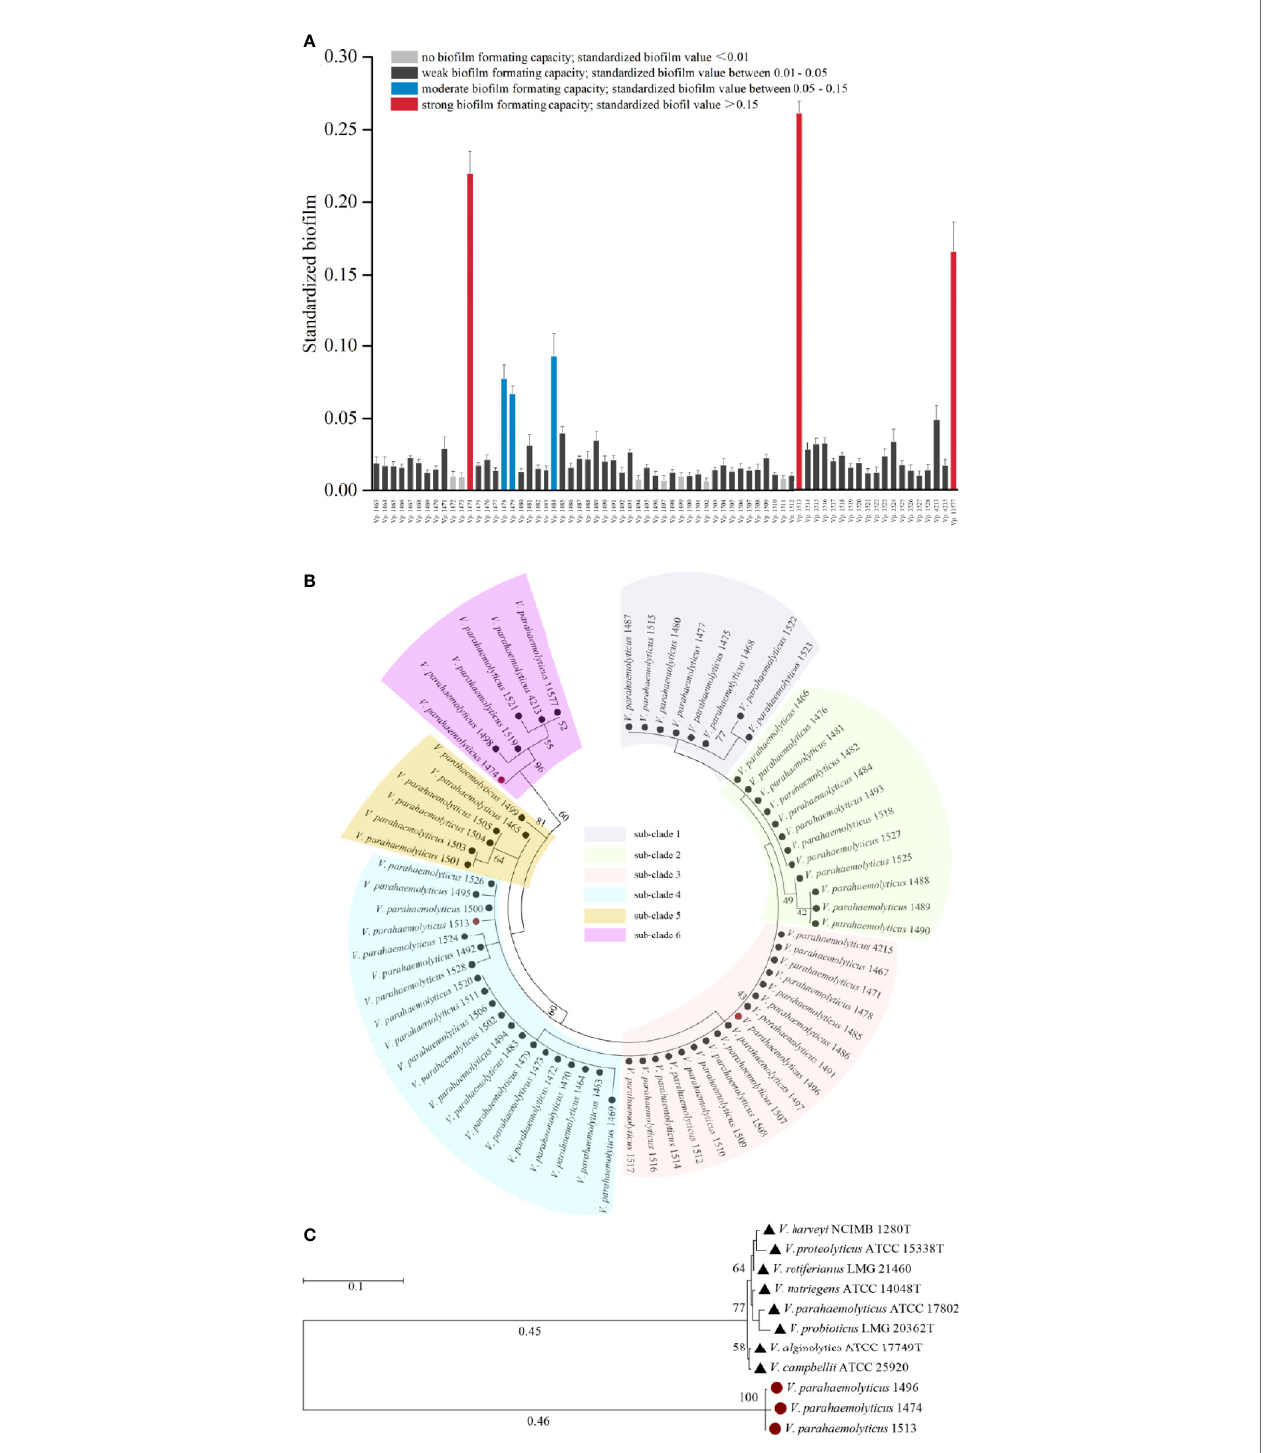
FIGURE 1 | Phylogenetic analysis and bio fi lm formation capacity of V. parahaemolyticus . (A) Standardized bio fi lms formed by 69 V . parahaemolyticus environmental strains. Based on the standardized bio fi lm values, the bio fi lm formation (BF) capacity of the strains was divided into four groups, viz., strong, moderate, weak, and no capacity. (B) Maximum likelihood tree of 69 V . parahaemolyticus environmental strains based on the 16S rDNA phylogenetic analysis. The bootstrap percentage value was obtained from 1000 samplings. The 69 strains were divided into 6 subclades. (C) Maximum likelihood tree for V. parahaemolyticus strains Vp . 1474, Vp . 1496, and Vp . 1513 based on the 16S rDNA phylogenetic analysis using type strains in Vibrio genus as reference. The bootstrap percentage value was obtained from 1000 samplings. Red solid circle: selected strains of Vp . 1474, Vp . 1496, and Vp . 1513; black solid triangle: reference Vibrio strains.